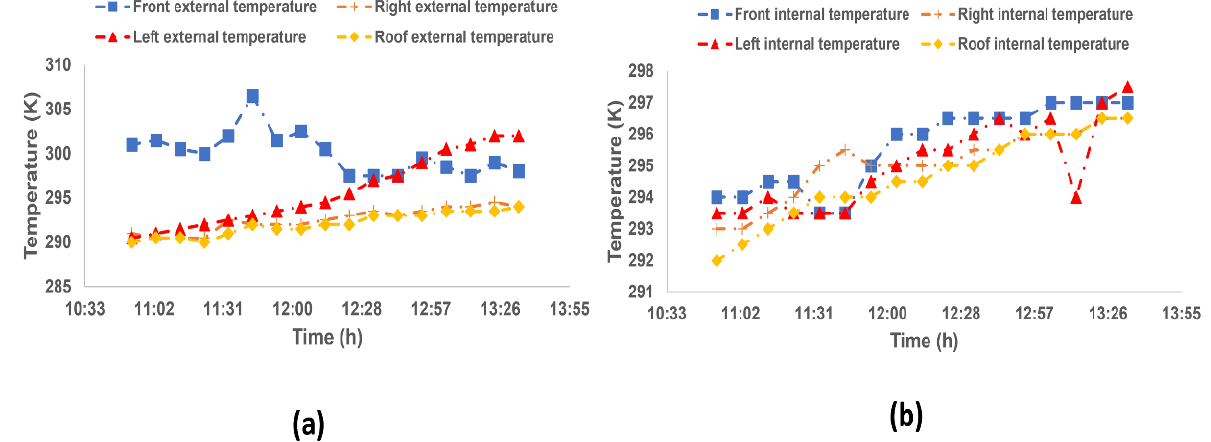
Figure 16. Time evolution of temperature: ( a ) External sensors; ( b ) Internal sensors. Figure 16b presents the temperature evolution given by internal temperature sensors.